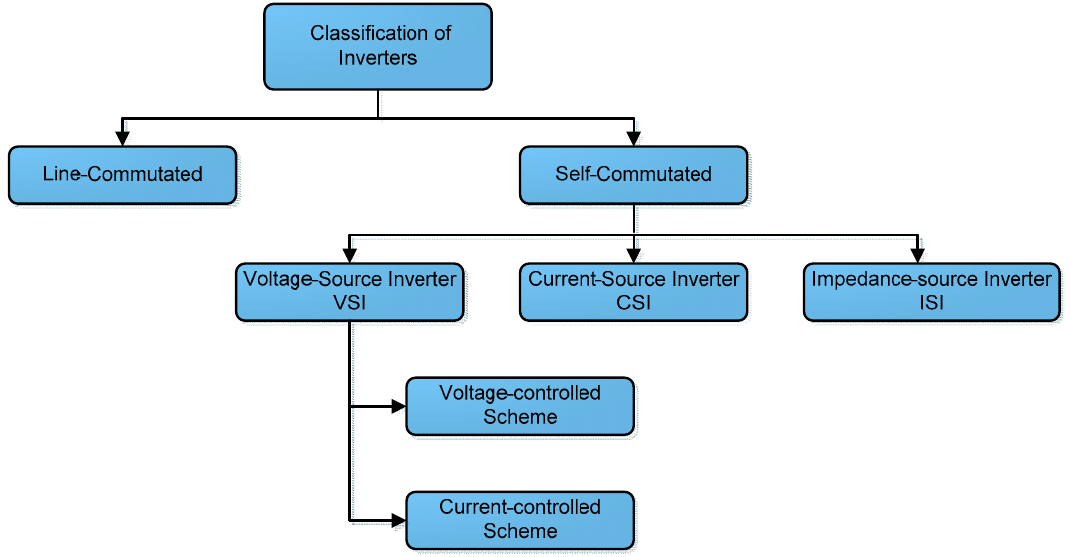
Figure 12. Classifications of inverters [66–69].